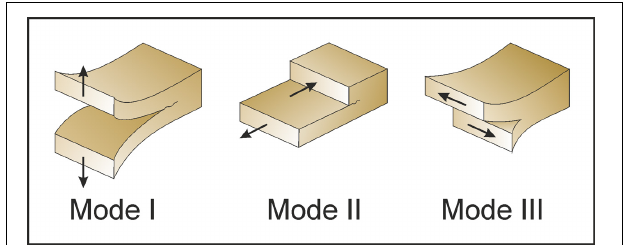
FIGURE 1 | Crack modes used in modeling rock fractures in a reservoir: In a mode I crack, the relative displacement is perpendicular to, and away from, the fracture plane (extension fractures). In mode II and III crack-tip displacement is parallel to the fracture plane: in mode II perpendicular, in III parallel to the leading edge (tip) of the crack. There are various combinations of these basic types (modified from Hudson and Harrison,